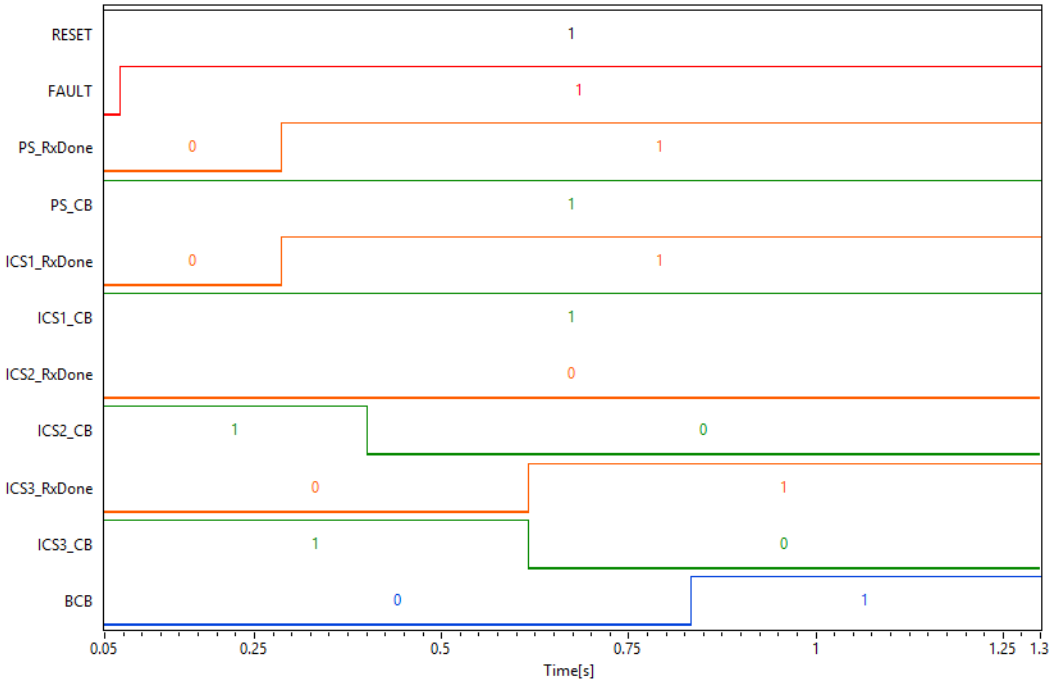
Figure 16. Digital signals acquired during the fault 67N.S1 between PR2 and PR3. Table 16. Estimated time intervals during the fault 67N.S1 between PR2 and PR3. Interval